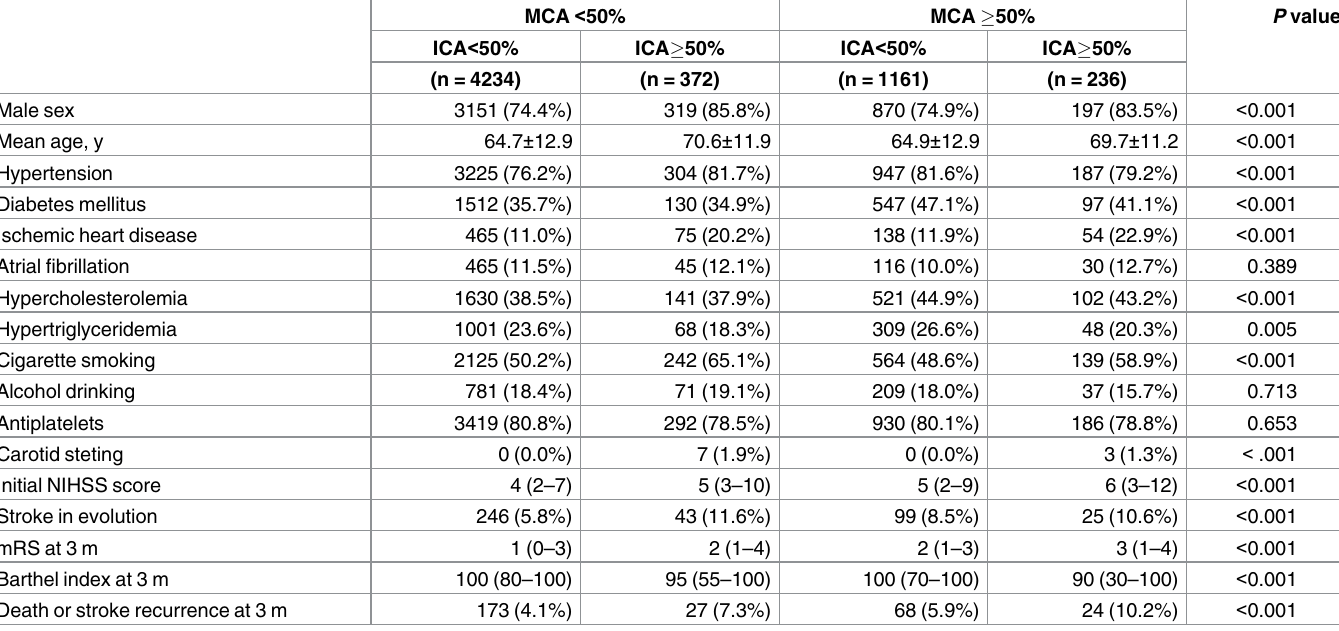
Table 3. Comparison among patients with or without stenosis of the MCA and